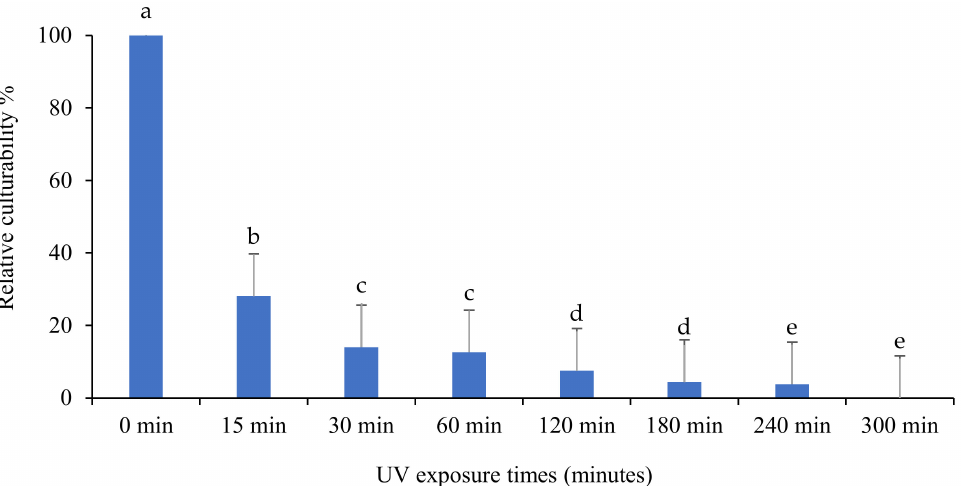
Figure 5. The impact of different UV-B exposure times on relative culturability percentage of Beauveria bassiana isolate “BbIDN-1”. The mean number of relative culturability percentage ± SE is shown. Different letters on the same patterned bars indicate significant differences (LSD test, p <